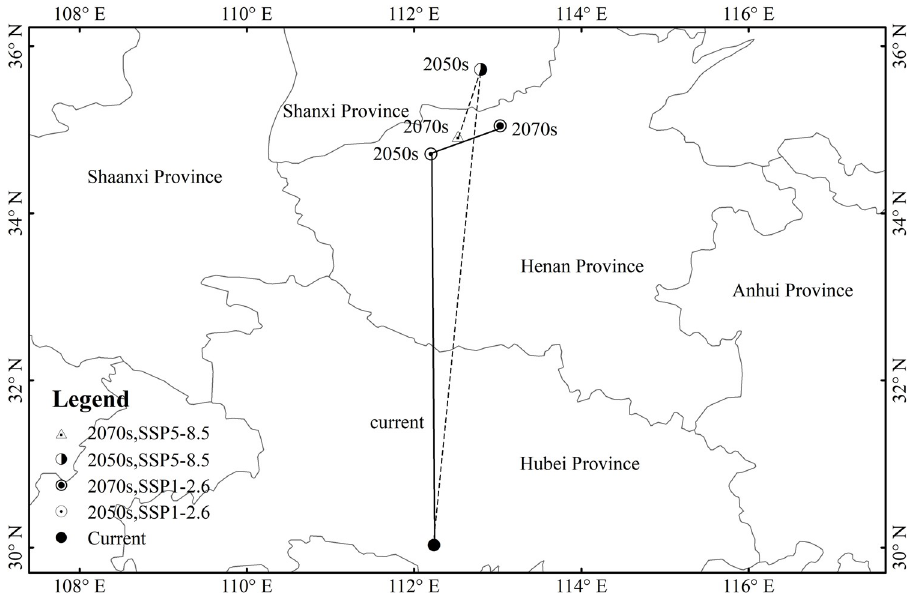
Fig 10. Changes in gravity center of the potential suitable habitat of P . tatarinowii and its moving tendency under future climate change scenarios.